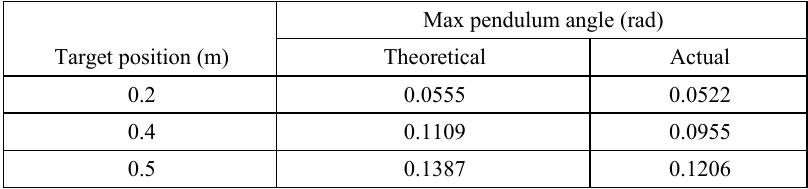
Table 4. Results in different target